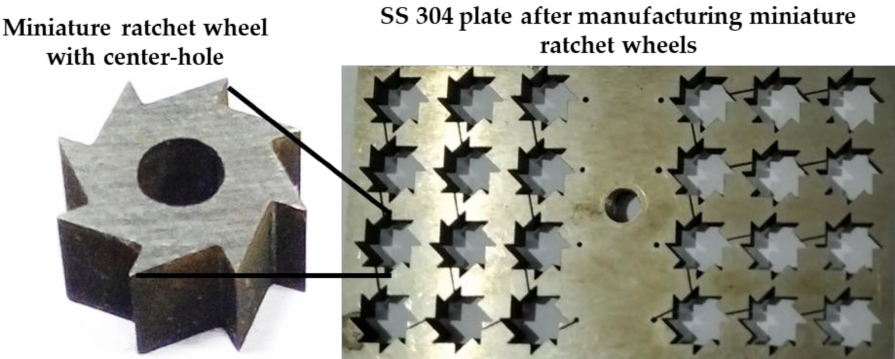
Figure 5. Miniature ratchet wheels manufactured by WSEM process from micro spark-erosion drilled SS 304 plate.